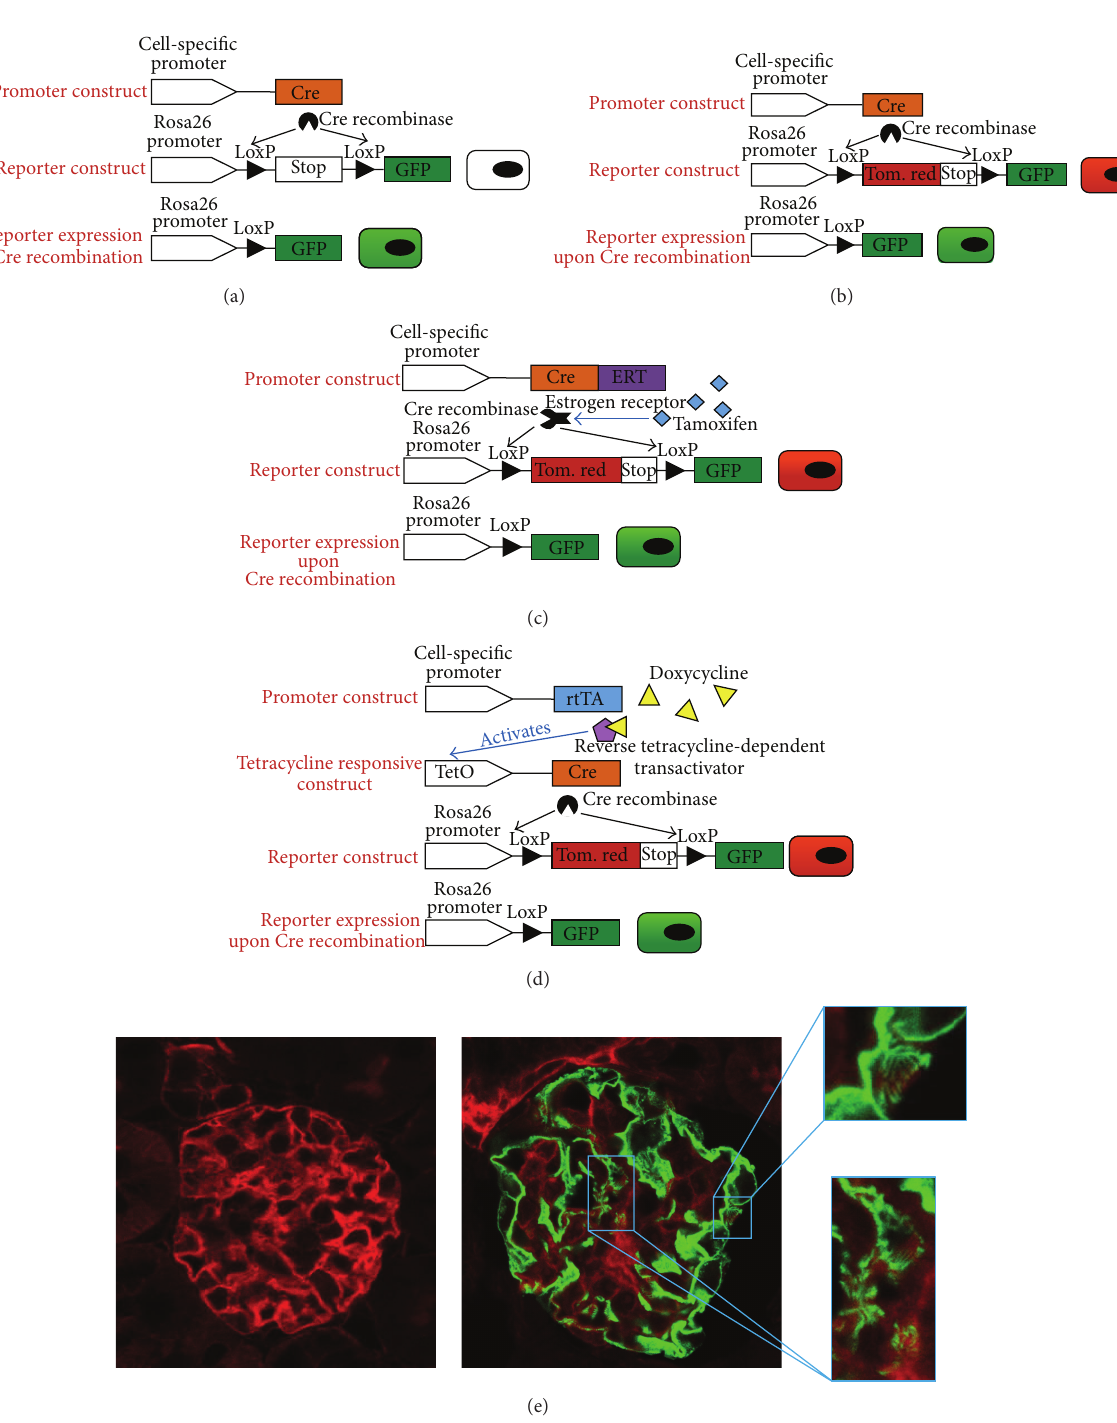
Figure 1: Schematic representation of the principal transgenic solutions. Each line represents a mouse strain, which is crossed with other transgenic strains in order to obtain double or triple transgenic animals. (a) Cell-specific promoter directly controls Cre activity creating a constitutive model. When the promoter gets activated Cre recombinase will be expressed and will gain access to LoxP sites. By removing the LoxP-floxed Stop cassette, the recombinatorial event will lead to GFP expression. (b) mT / mG (membrane-Tomato/membrane-Green) reporter construct in a constitutive scheme. The cell-specific promoter, in this setting, will change desired population color from ubiquitously expressed tomato red protein to GFP, evidencing cells that had recombinatorial activity. (c) Inducible model based on a fused form of Cre recombinase and estrogen receptor (ERT) proteins. If the chosen promoter is activated this fused protein will always be transcribed. Only following Tamoxifen treatment the ERT will bind the inductor and enter the nucleus, where Cre recombinase will act on the LoxP site of the reportertransgene mT / mG .(d)InduciblemodelbasedonreverseTetracycline-controlledtransactivator(rtTA)protein,whichiscontinuously created by the activated specific promoter. When bound to Tetracycline (Doxycycline form), the transcriptional factor is able to activate Cre transcription controlled by TetO operator sequences. (e) Imaged glomeruli in a podocyte-driven mT / mG setting prior to (left panel) and following (right panel) induction. The strong fluorescence signal of this reporter line enables the visualization of podocyte primary foot processes (right enlarged